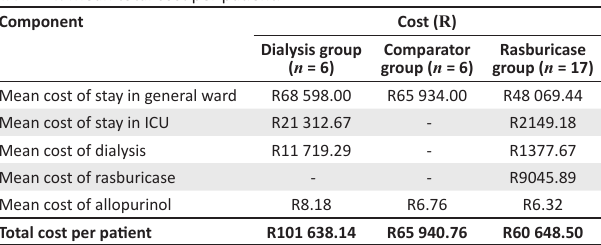
TABLE 4: Mean total cost per patient.